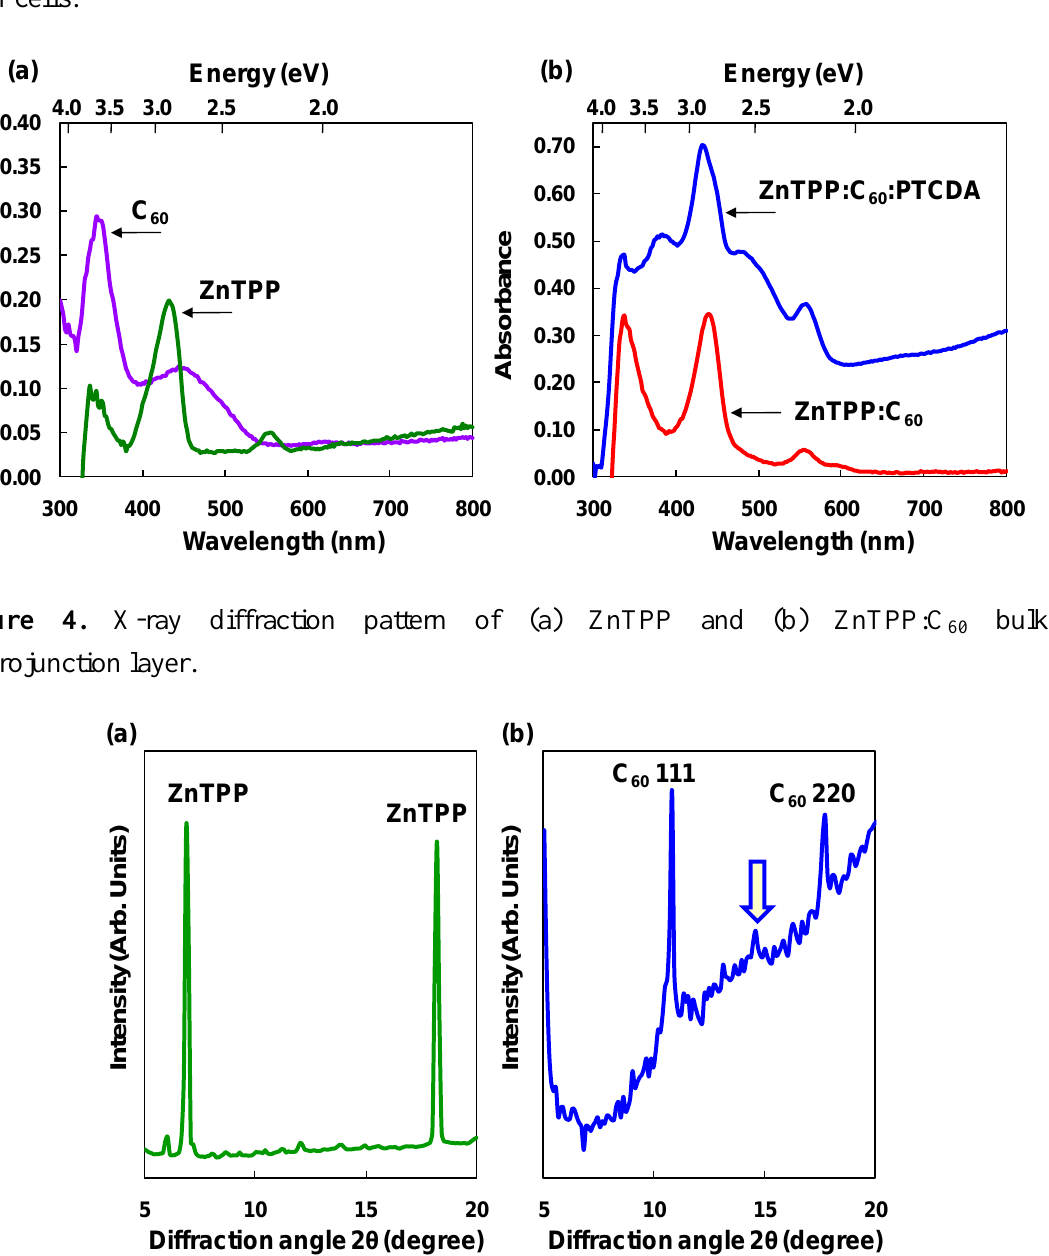
Figure 3. Absorbance spectrum of (a) C solar cells.